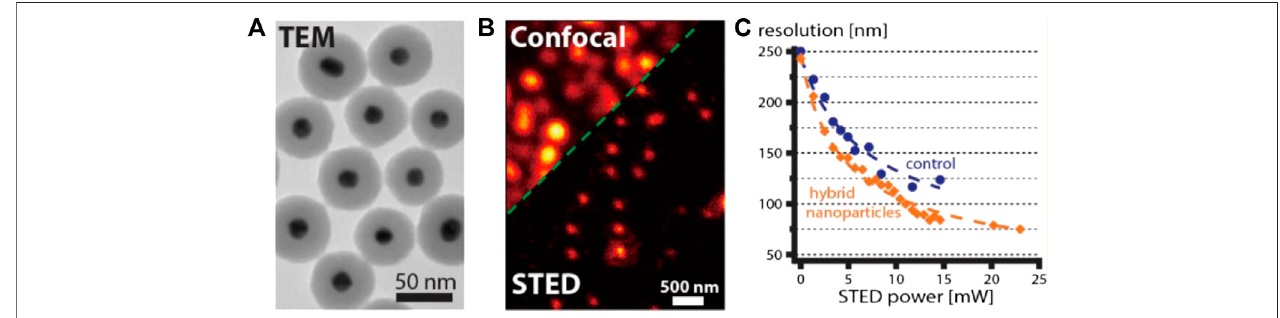
FIGURE10| STEDperformanceoftypicalLPRhybrids(Urbanetal.,2018). (A) Thetransmissionelectronicmicroscopy(TEM)imageofLPRhybridssynthesizedby Urban et al. (B) Confocal and STED imaging results of single LPR hybrid particles. (C) The comparison of resolution enhancement for dye-doped particles with and without (control) LPR effect under different STED